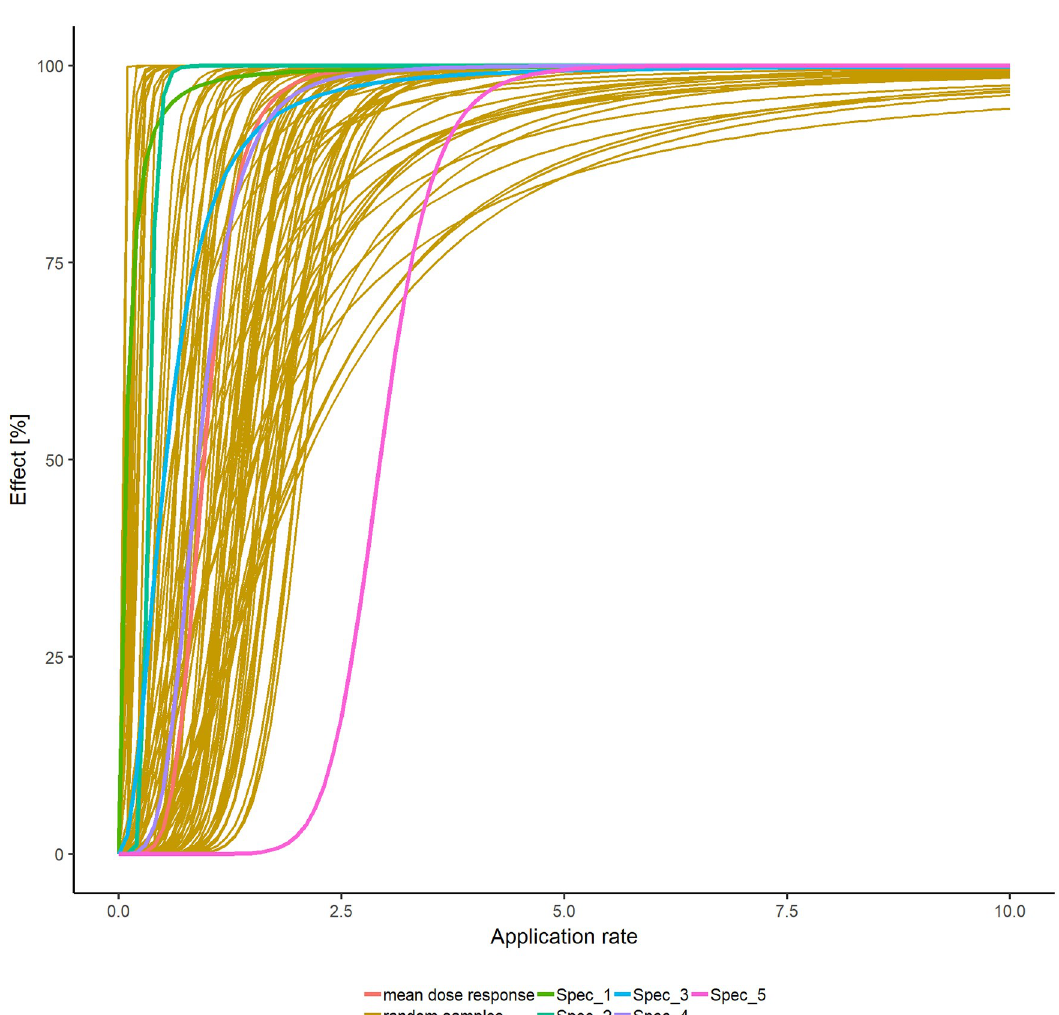
Fig 3. Example of calculated dose responses based on empirical data of 5 plant species. Red line represent the mean dose response (with mean of the estimated EC50 and slope b ), orange lines represent 100 random dose responses based on the mean and standard deviation of the estimated EC50 and slope b